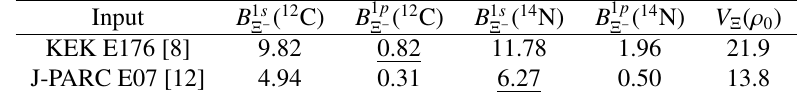
Table 2. Ξ − – 12 C and Ξ − – 14 N binding energies in 1 s and 1 p states, B 1 s V Ξ ( ρ 0 ) at nuclear-matter density ρ 0 = 0 . 17fm − 3 calculated using a density-dependent optical potential Eqs. (1,2) with Re b 0 fitted to binding energies underlined for each input choice. All entries are in MeV.